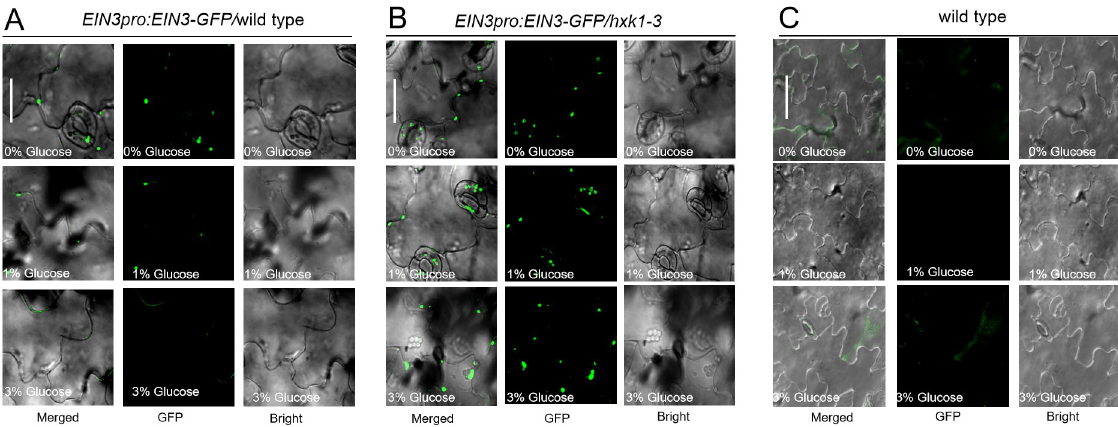
Fig 2. Transiently applied glucose suppresses EIN3, dependent on HXK1 function. A, B and C , Images illustrating the nuclear localization of EIN3pro:EIN3-GFP in leaf blades of 5-day-old EIN3pro : EIN3-GFP in wild-type (A) and hxk1-3 (B) background. Wild type was used as negative control (C). These seedlings were grown on MS medium with 1%, 3% glucose or without for 5 days. Bar = 20 μ m. Three biological replicates were analyzed for each pair and one representative result was presented.